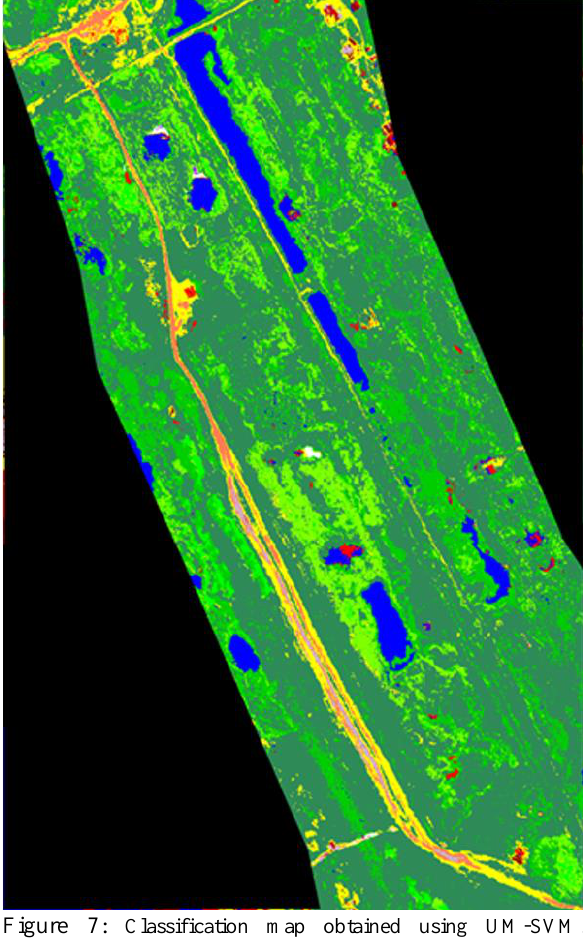
Figure 7: Classification map obtained using UM-SVM. Legend: Blue: water (EM10), Yellow: Bare soil/very sparse vegetation (EM19), Very dark green: Stressed vegetation (EM6), Dark green: Green vegetation (EM13,14), Green: Green vegetation (EM 1,18,20), Light green: Green vegetation (EM3). Other colors: man-made and bare soils (EM 5, 7, 11, 12, 16,